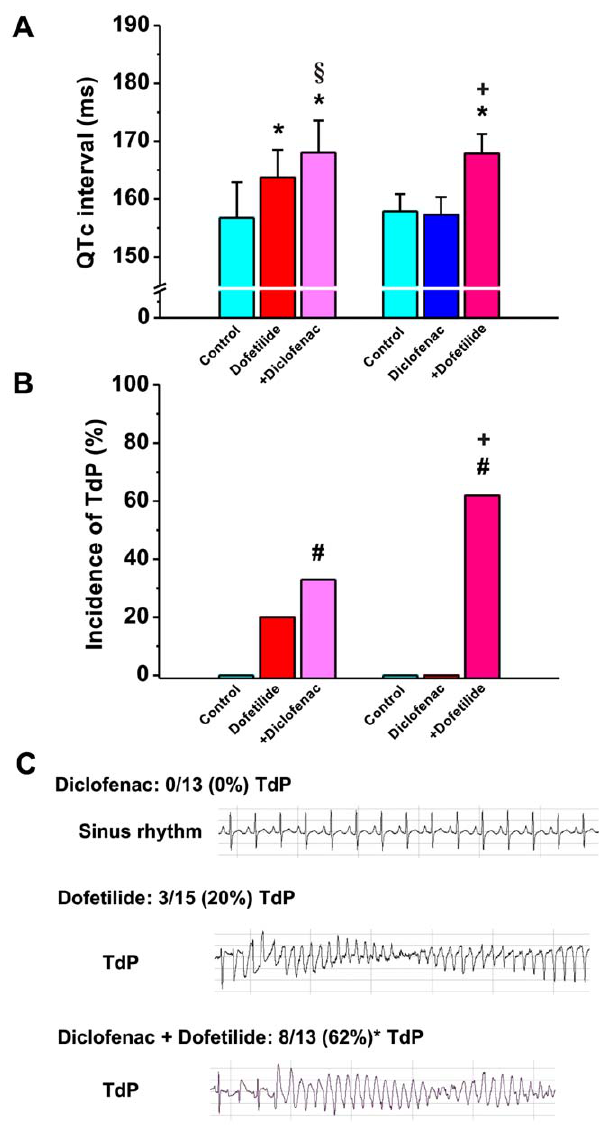
Figure 3. Effect of diclofenac on repolarization and TdP incidence in anesthetized rabbits. ( A ) Frequency corrected QT intervals (QTc) and ( B ) incidence of Torsades de Pointes ventricular tachycardia (TdP) in anaesthetized rabbits before and following dofetilide (25 m g/kg), dofetilide + diclofenac (3 mg/kg) and diclofenac, diclofenac + dofetilide administration. *p , 0.05 vs. control, + p , 0.05 vs. diclofenac, 1 p , 0.05 vs. dofetilide, n=15 and 13 animals/group, respectively. ( C ) Representative ECG recordings illustrate TdP de- velopment only after dofetilide or diclofenac + dofetilide combination, but not following diclofenac administration. # p , 0.05 vs. baseline, n=13 and 15 animals/group, respectively.